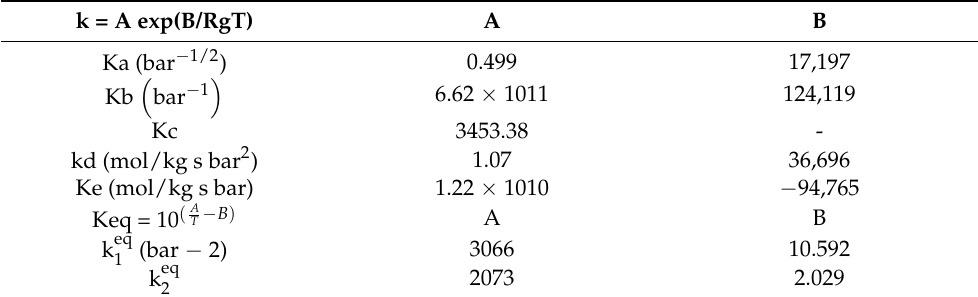
Table A2. Kinetic and equilibrium constants [25,26].